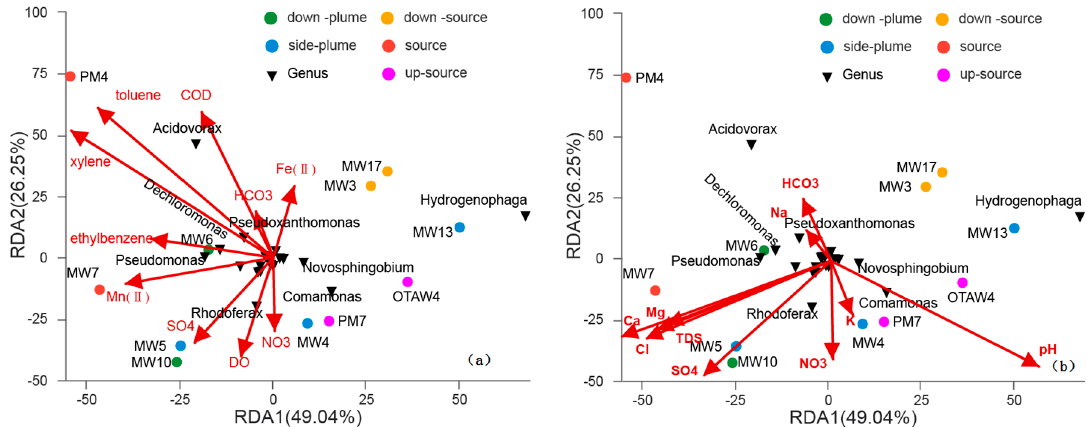
Figure 5. Redundancy analysis (RDA) of the relationship between the groundwater parameters and the relative abundance of the bacterial genus of the collected samples. The contamination indexes and the electron acceptors are mainly shown in ( a ); while the major ions, TDS, and pH are mainly shown in ( b ).